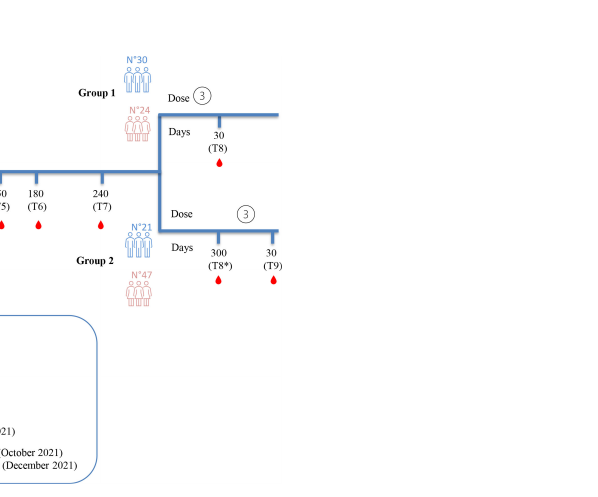
FIGURE 1 Study design. Blood collection at the indicated time points (T1 to T7) refers to the daysafter the fi rst vaccine dose. After 240 days from the fi rst dose, the study cohort was divided intotwo groups. Group 1 underwent the third dose 9 months after the fi rst dose. Time points of Group1 are T1, T2, T3, T4, T5, T6, T7 and T8 (30 days after the third dose). Group 2 underwent the thirddose 11 months after the fi rst dose, two months later than Group 1. Time points of Group 2 are T1,T2, T3, T4, T5, T6, T7, T8* (300 days after the fi rst dose) and T9 (30 days after the third